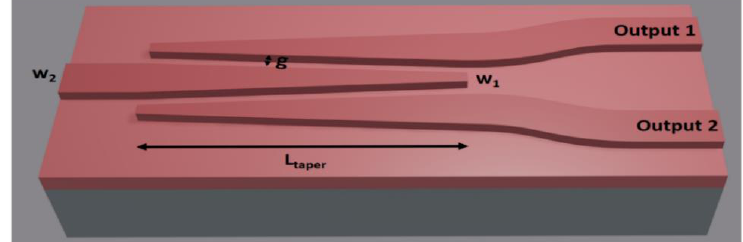
Figure 2. Schematic of 3-dB tapered rib waveguide optical power splitter. Structures in red and grey are silicon (Si) and buried oxide (BOX), respectively.